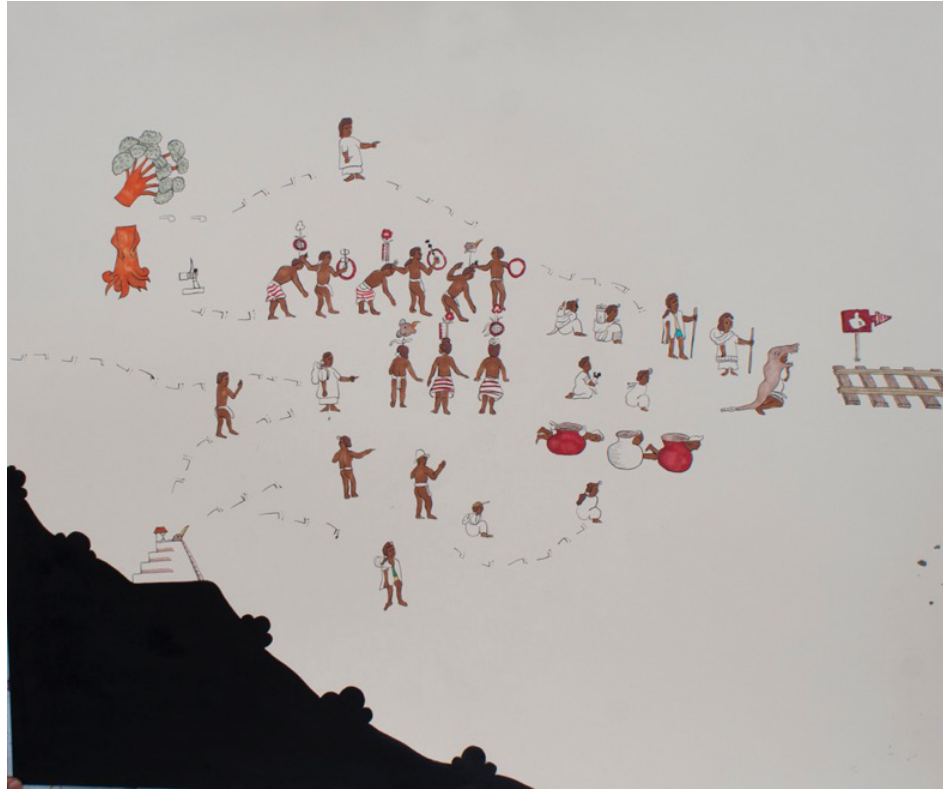
Gabriel Garcilazo, Dystopic Magical Codex: Codex 14 (Immigrants from Central America Join the Same Route) , 2015. Charcoal and ink on paper. 59 x 76 cm. Private collection. Image courtesy of the